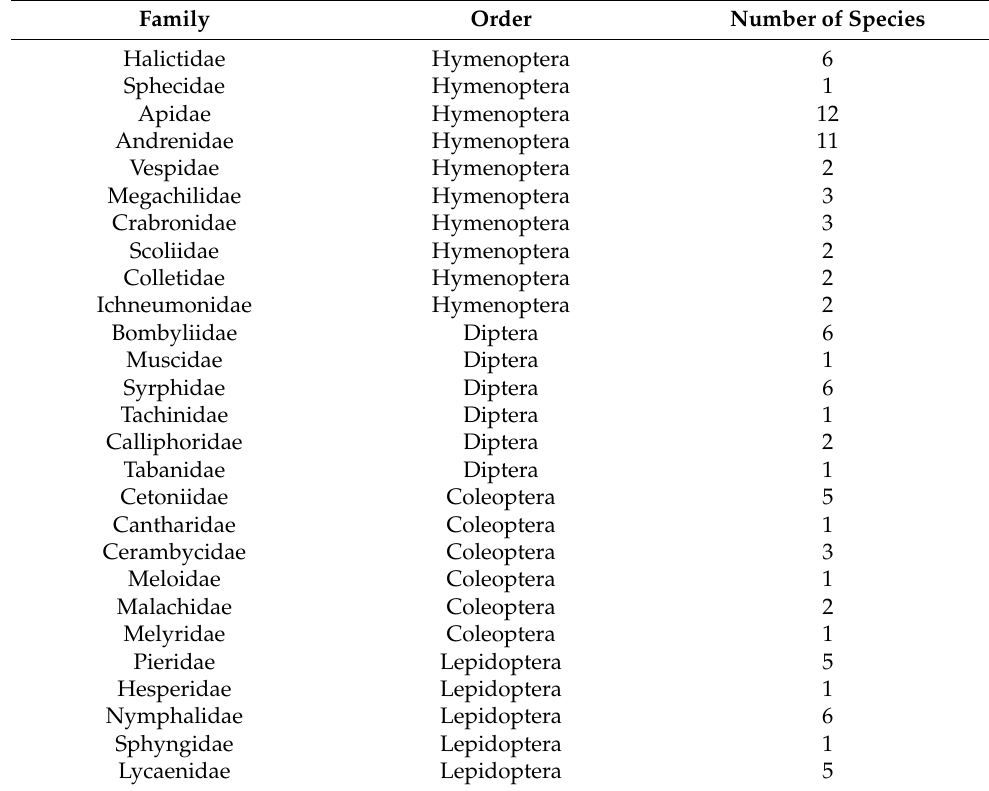
Table 4. Pollinating species numbers appeared in the implanted margins.